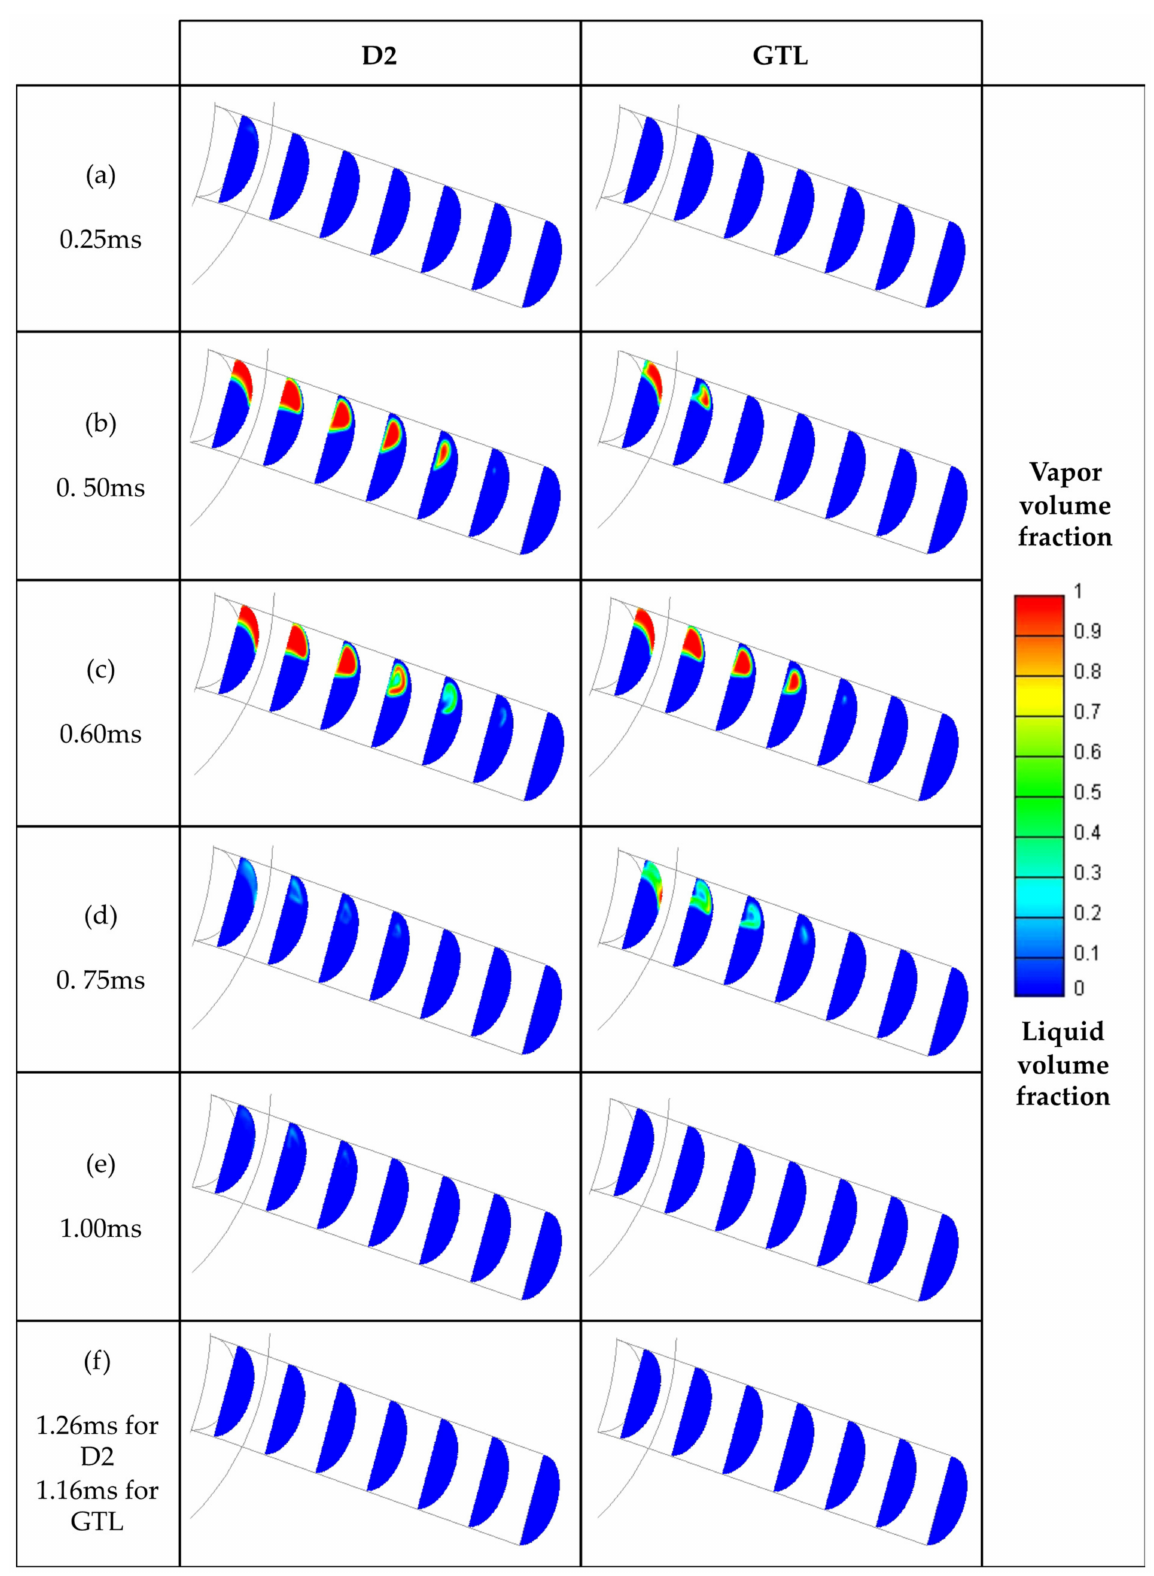
Figure 12. Vapor Volume Fraction at 80 bar of in-cylinder